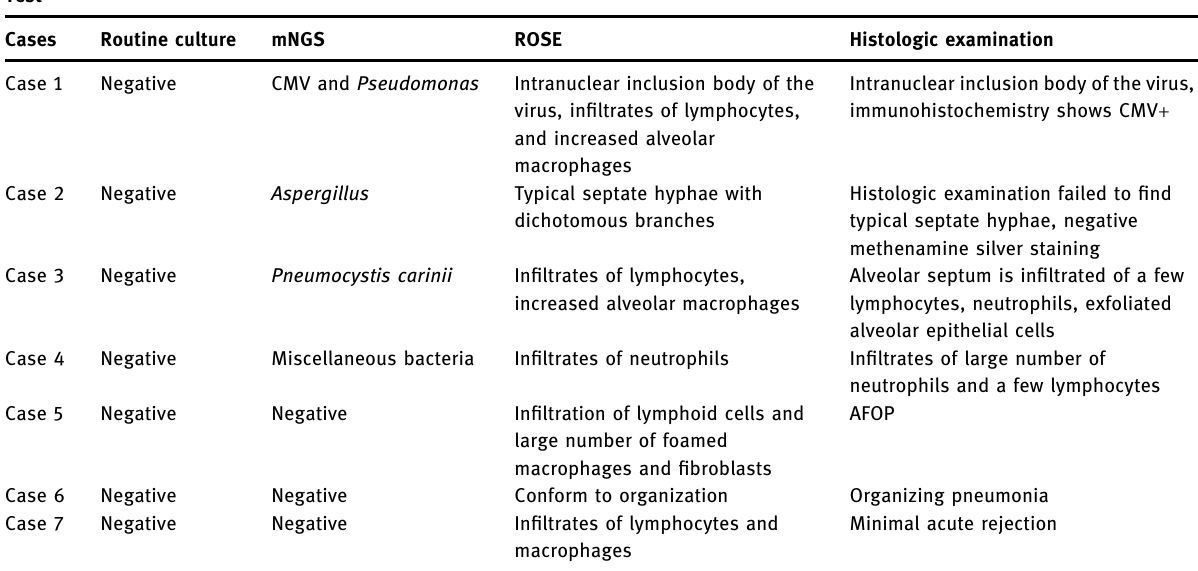
Table 2: Routine culture, mNGS, ROSE, and histologic examination fi ndings